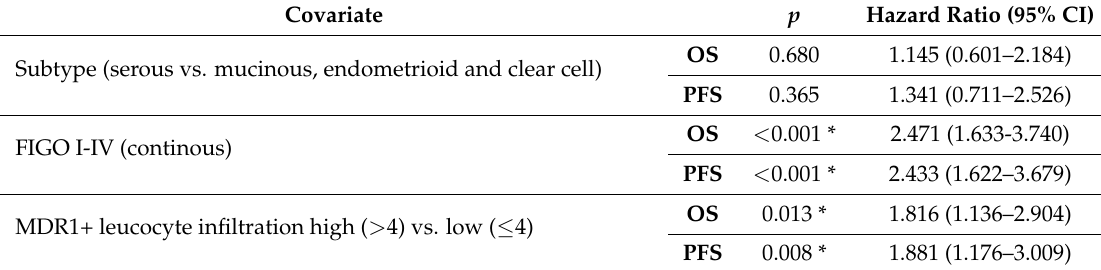
Table 3. FIGO and a high MDR1 + leucocyte infiltration are independent prognostic factors for OS and PFS.